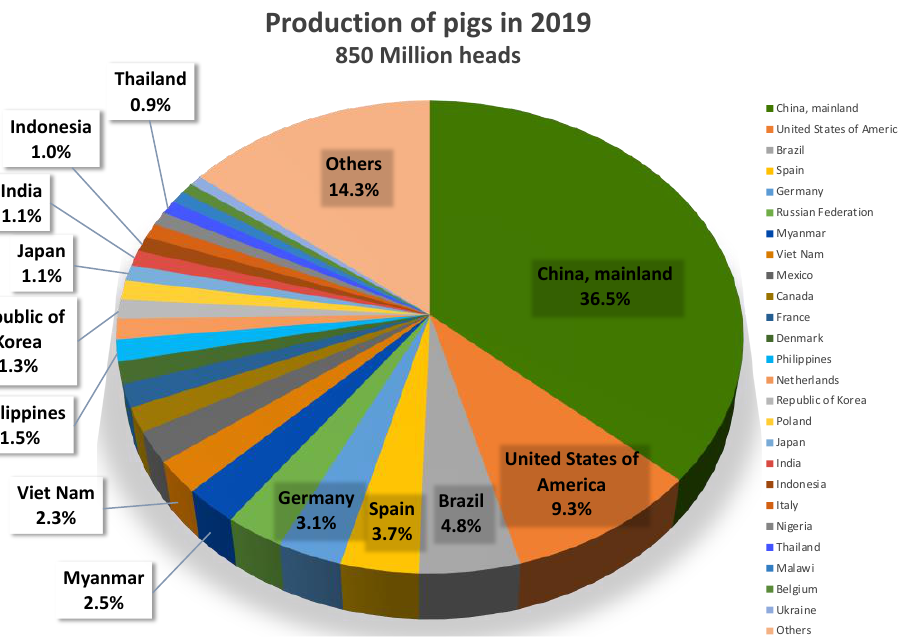
Figure 1. The top five pig-producing countries worldwide and the top nine pig-producing Asian countries. Data was obtained from FAOSTAT (http://www.fao.org/faostat/en/#data/QCL, accessed on 9 July 2021).